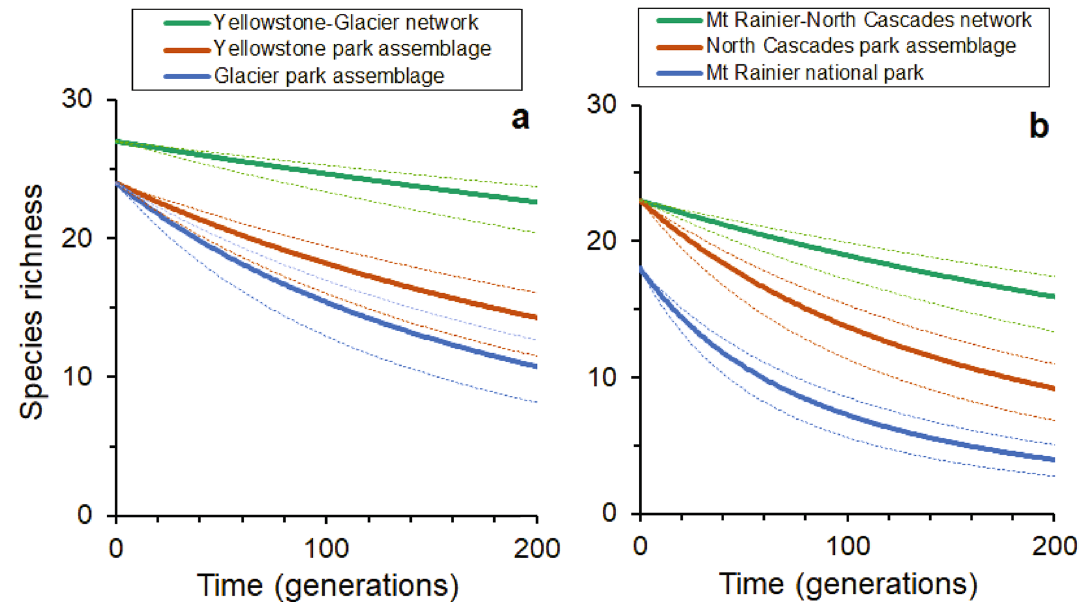
Figure 4. Comparison of projected change in medium to large mammal species number over 200 generations in ( a ) the Yellowstone-Glacier and ( b ) the Mount Rainier-North Cascades protected area networks with individual park/park assemblages. The upper and lower dashed lines are the loci of Eq. (6) for which t 50 is replaced by t 50 + δ t 50 and t 50 − δ t 50 respectively. These lines represent the uncertainty in predictions which reflect the fact that the model parameters are estimated from a large number of studies of mammals in different